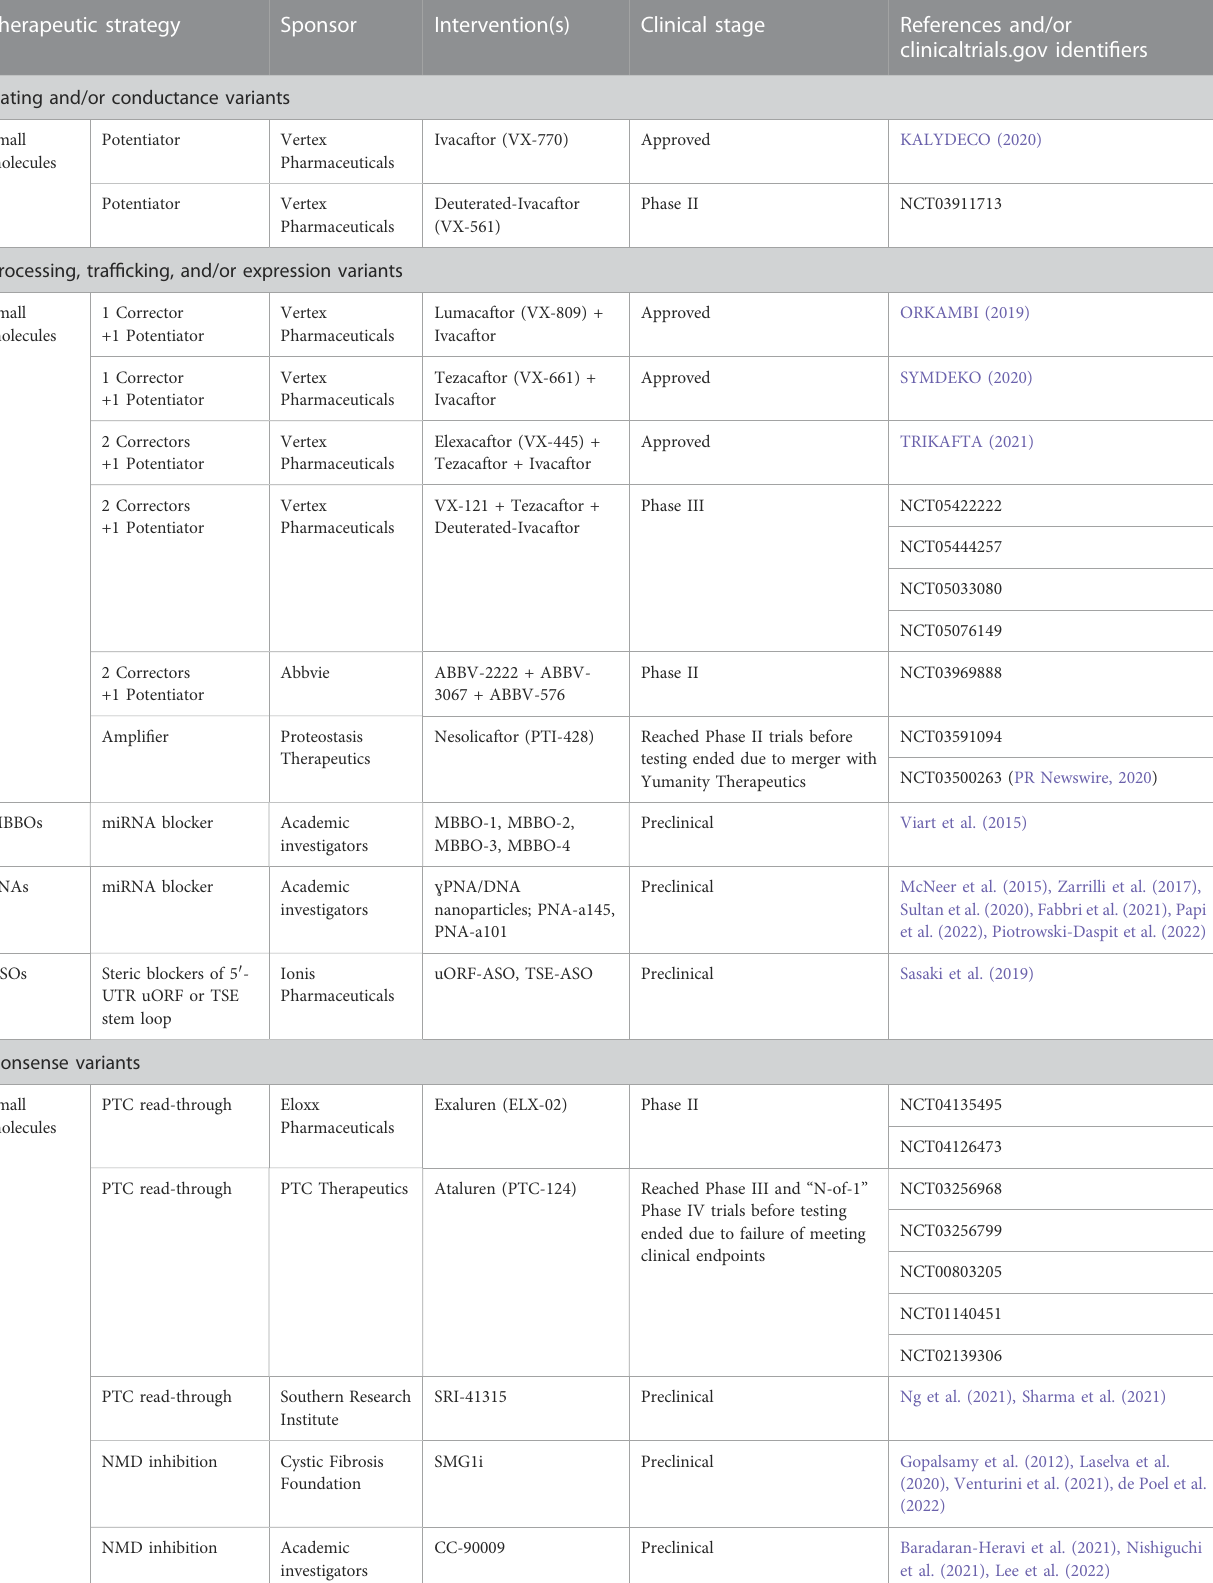
TABLE 1 Therapeutic strategies presently employed for CF. Clinically approved agents are emphasized, as well as interventions undergoing clinical trials or advanced preclinical testing. Abbreviations: miRNA-binding blocker oligonucleotide (MBBO); peptide nucleic acid (PNA); antisense oligonucleotide (ASO); upstream open reading frame (uORF); translation suppression element (TSE); premature termination codon (PTC); nonsense-mediated decay (NMD); anticodon edited (ACE) transfer RNA (tRNA); exonic splicing enhancer (ESE); lipid nanoparticle (LNP); adeno-associated virus